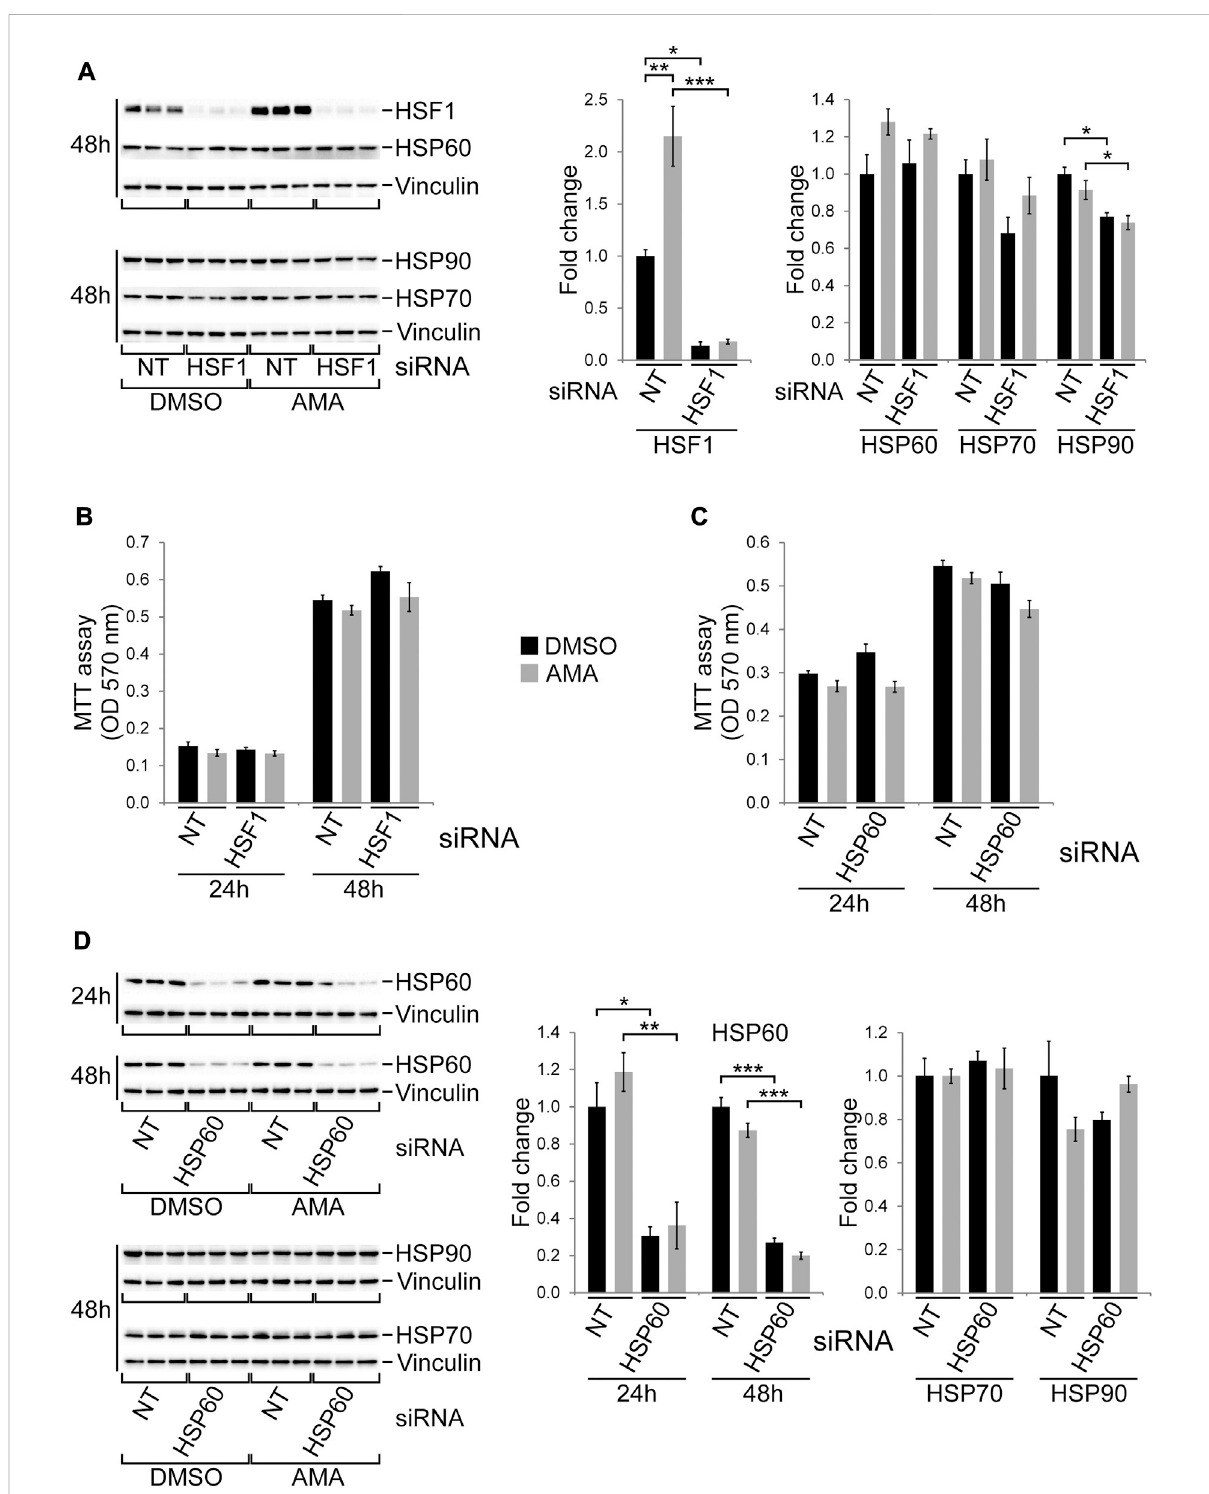
HSF1 and HSP60 are not required for growth and survival of H9c2 cells upon antimycin A treatment. (A) Western blots showing protein expression of HSF1 and various chaperones in H9c2 cells transfected with non-target (NT) or HSF1 siRNA and subsequently treated with DMSO or AMA (50 µM) for 24 and 48 h. (B) MTT assays of H9c2 cells treated as outlined in (A) [ n = 3 wells per treatment in (A) and (B) ]. (C) MTT assays of H9c2 cells transfected with non-target (NT) or HSP60 siRNA and subsequently treated with DMSO or AMA for 24 and 48 h. (D) Western blots showing protein expression of HSP60 and other chaperones in H9c2 cells treated as outlined in (C) [ n = 3 wells per treatment in (C) and (D) ]. (* p < 0.05, ** p < 0.01, *** p < 0.001)